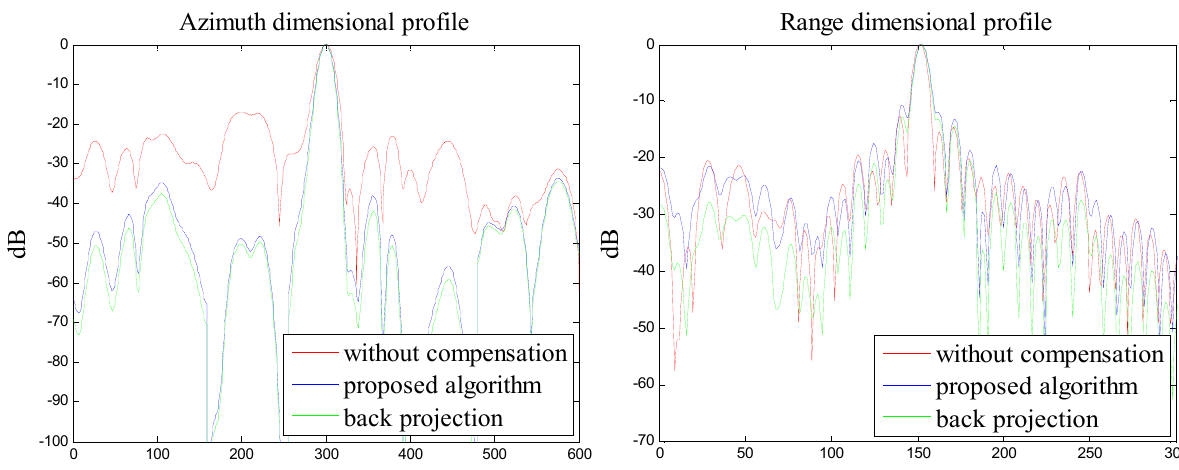
Figure 12. The profile response of the trihedral angle reflector labeled